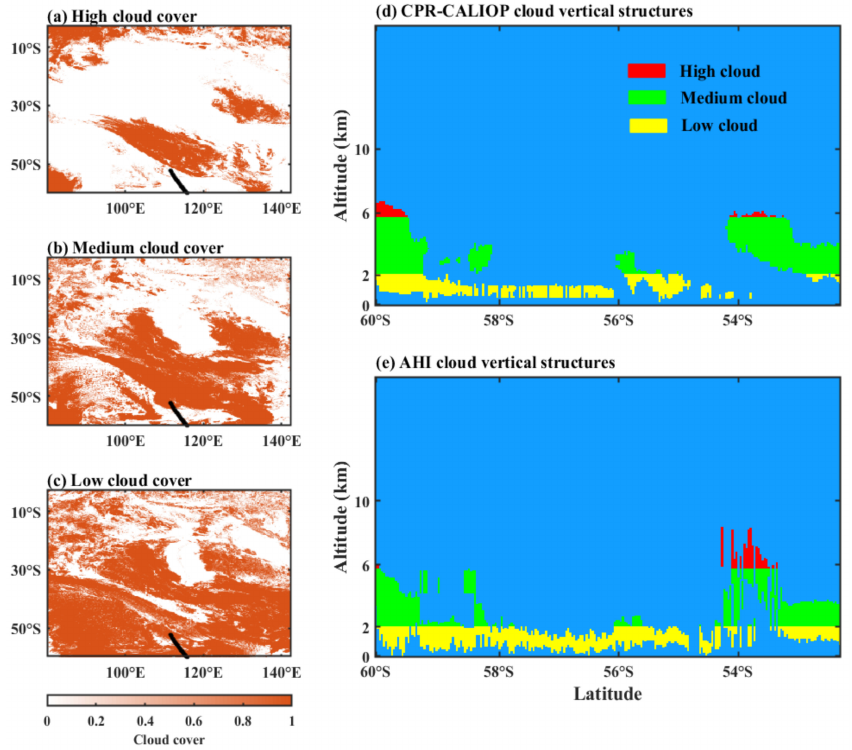
Figure 7. Example of a layered cloud cover estimate on October 5, 2017 at UTC 07:00, with ( a – e ). The black lines in ( a – c ) represent the tracks of CPR-CALIOP, corresponding to the results in ( d , e